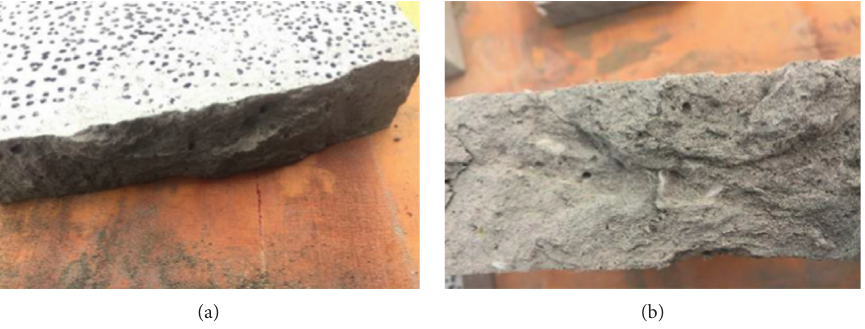
Figure 10: Breakage of wall along cracks.